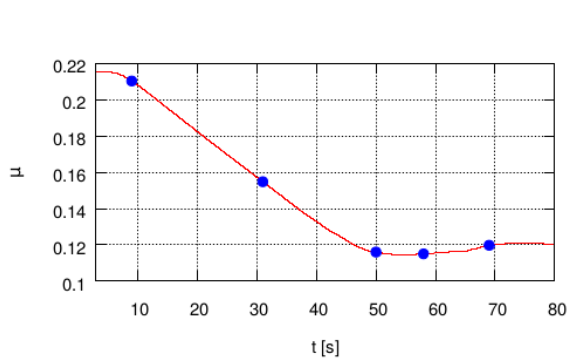
Figure 2: Advance ratio time history in maneuver